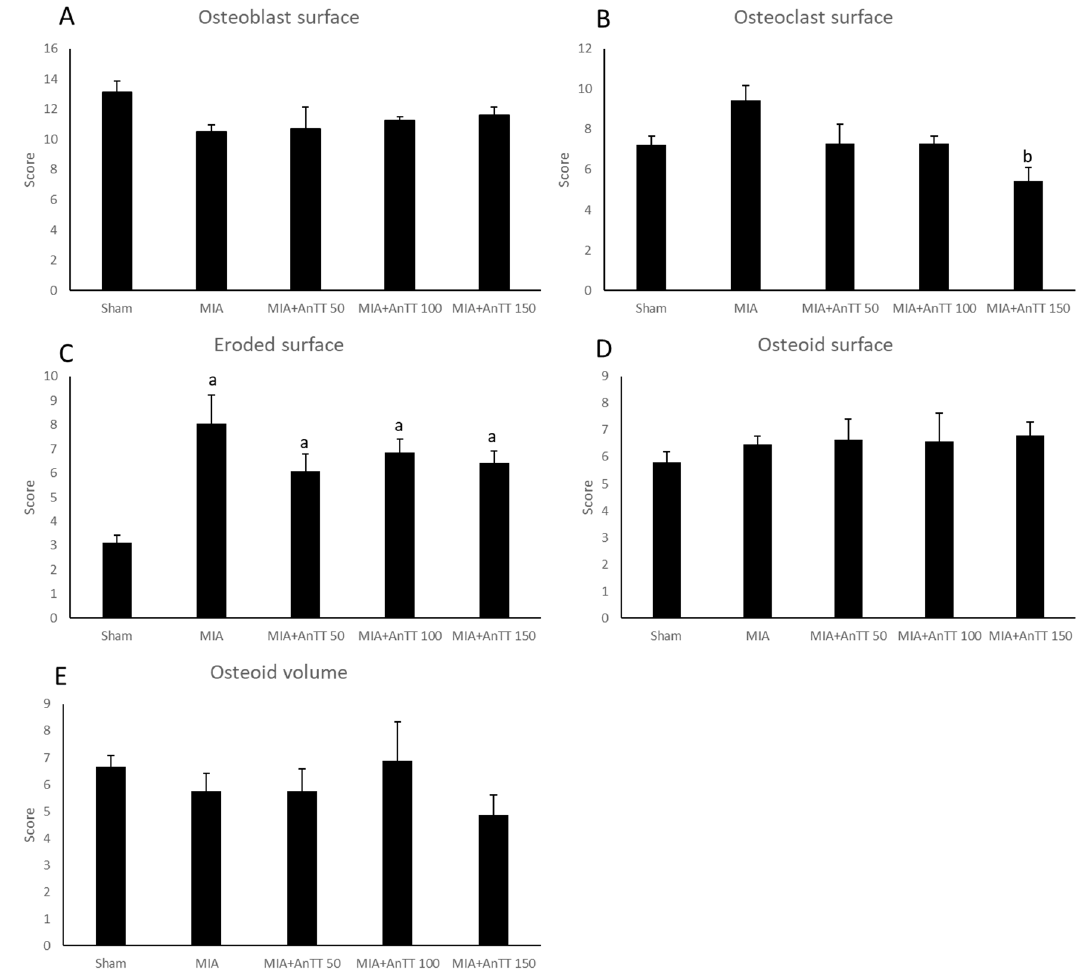
Figure 5. Cellular indices of subchondral bone after treatment: osteoblast surface ( A ); osteoclast surface ( B ); eroded surface ( C ), osteoid surface ( D ) and osteoid volume ( E ). The data are shown as mean with standard error of the mean. Letter ‘a’ indicates significant difference versus the sham group; ‘b’ versus the MIA group. Abbreviation: AnTT, annatto tocotrienol.